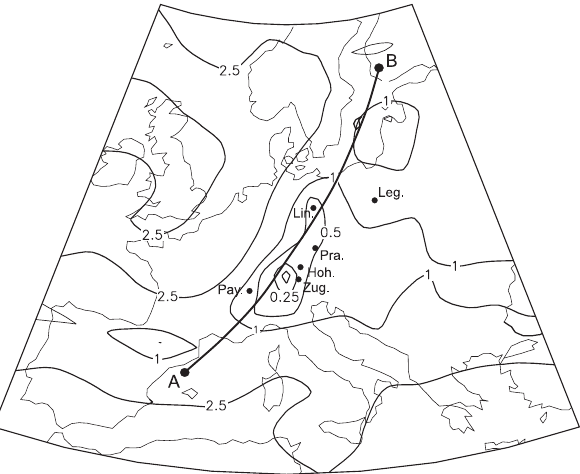
Fig. 13. Specific humidity [g/kg] at the 700 hPa level from NCEP/NCAR reanalysis data for 17 March, 6 UTC. The line in- dicates the cross section used in Fig.